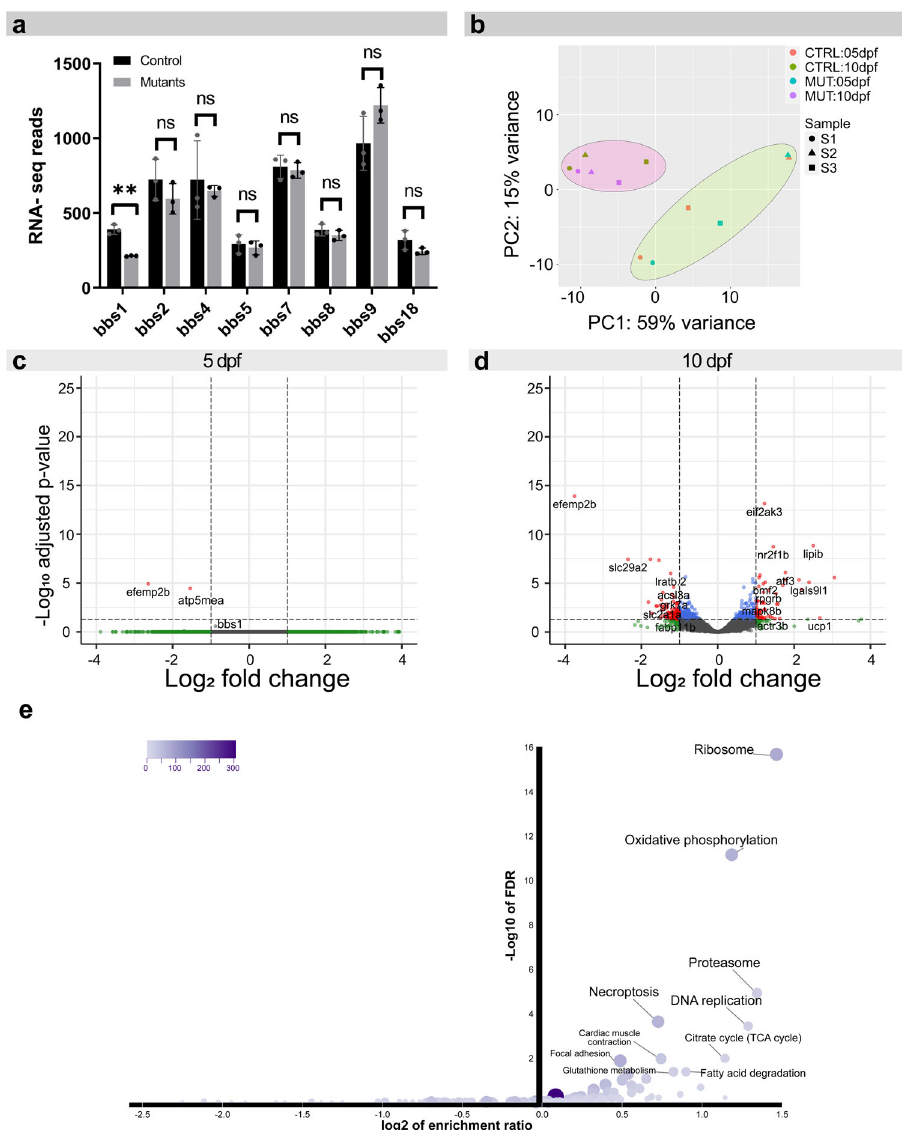
Fig. 4 The retinal transcriptome is not primarily affected in bbs1 mutants. Eye-speci fi c transcriptomic analysis in 5dpf and 10dpf maternal zygotic bbs1 − / − larvae and their sibling controls. a Bar plot of the normalized read counts of all BBSome components at 10dpf shows a signi fi cant reduction in bbs1 mRNA, indicating mutation-induced mRNA decay. No signi fi cant alteration in mRNA levels of other BBSome components was observed, indicating that no transcriptional compensation effect occurs. Benjamini-Hochberg (BH) adjusted P values of Wald test; Sig: ** = adj. P value = 0.006.; Sample size ( n = 3 samples for each condition, composed of a pool of >10 larvae); Error bars show standard deviation around the mean. b Principle component analysis of the Deseq2 normalized, variance-stabilizing transformed top 100 variable genes, shows large variability between sample pairs (batches) at 5dpf and to a lesser extent at 10dpf. c – d DE genes are visualized in volcano plots by their fold change (FC) (mutant over control) and their adjusted P value. To account for batch effects shown in ( b ), a paired sample design was considered in the differential expression (DE) analysis following the two-sided Wald test. In red are genes with an adjusted P <0.05 and fold change >FC±2; in blue are genes with adj . P <0.05 & FC between + 2 and − 2 and in green are genes with a FC>±2 but an adj. P >0.05. c DE-analysis at 5dpf reveals only two genes that are signi fi cantly changed; neither are associated to a known developmental or BBSome compensation pathway. d At 10dpf several genes are signi fi cantly DE (red dots). e Over-representation analysis was used to group the genes that were DE at 10dpf into functional groups using Webgestalt KEGG-pathway analysis. Several KEGG pathway terms associated with metabolic change and necroptosis were overrepresented in our data set. Abbreviations: CTRL control, MUT mutant, DE differential expression, FC fold change ( mzbbs1 − / − over